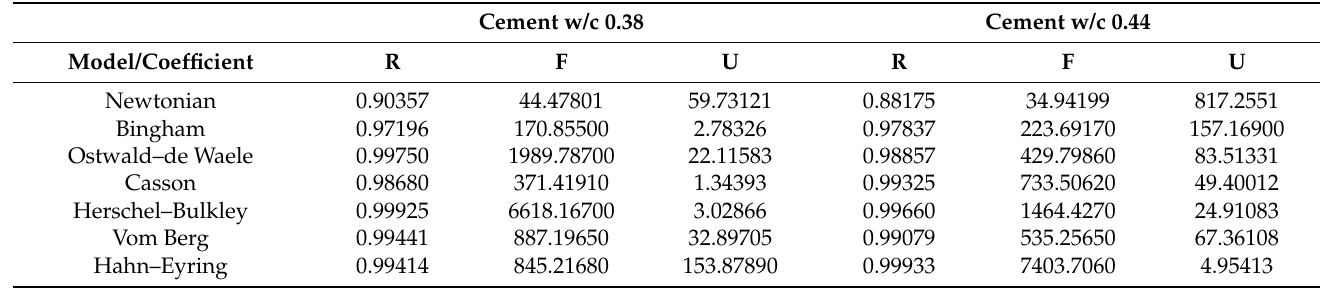
Table 5. Results of the rheological model selection obtained from Rheosolution for cement slurry Table 4. Fluid rheological parameters obtained from Rheosolution for cement slurry reference sam- ples.